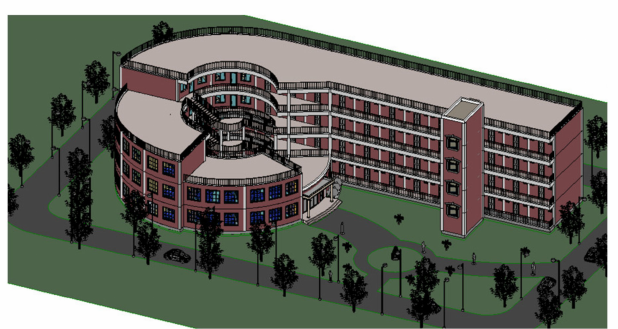
Figure 7. Model renderings.